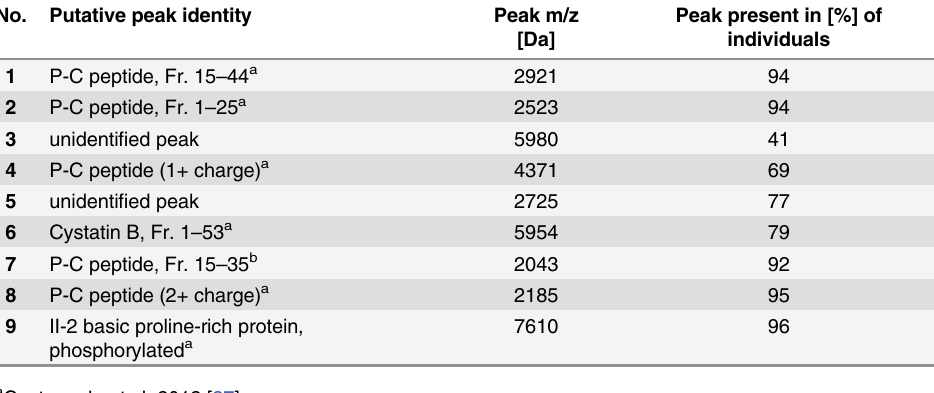
Table 2. Peaks identified by Unsupervised Feature Selection to be determining the subgroups found by Spectral Clustering. Peaks are listed in decreasing order of their effect on the clustering. No. Putative peak